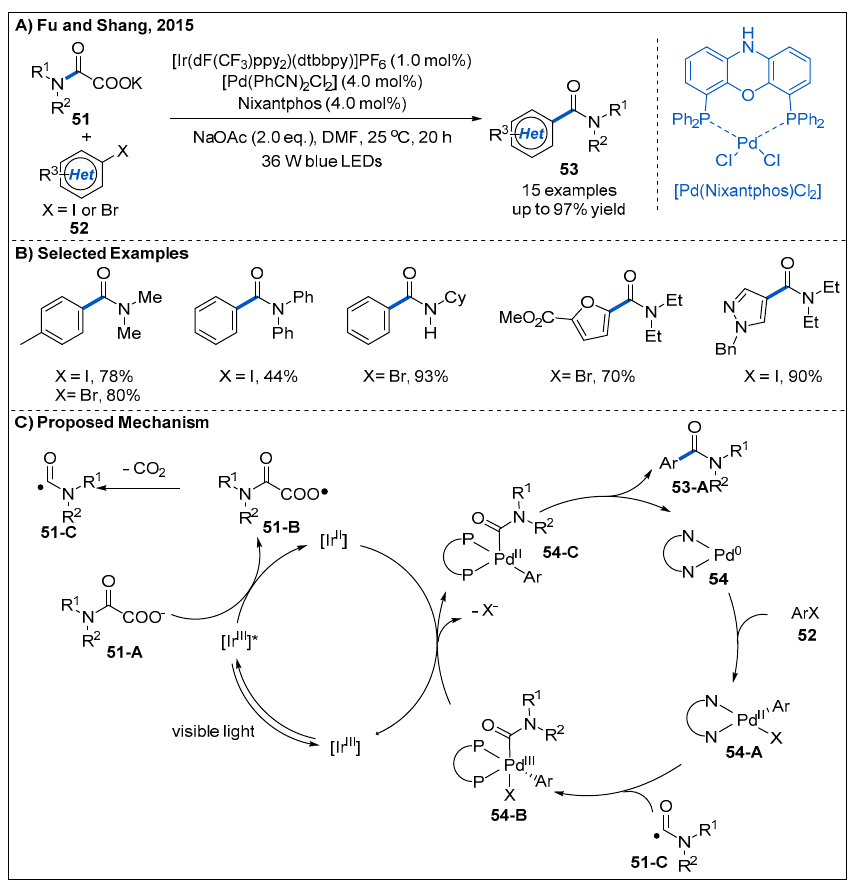
Figure 17. Photoredox-catalyzed cross-dehydrogenative coupling (CDC) reaction for the synthesis of amides.